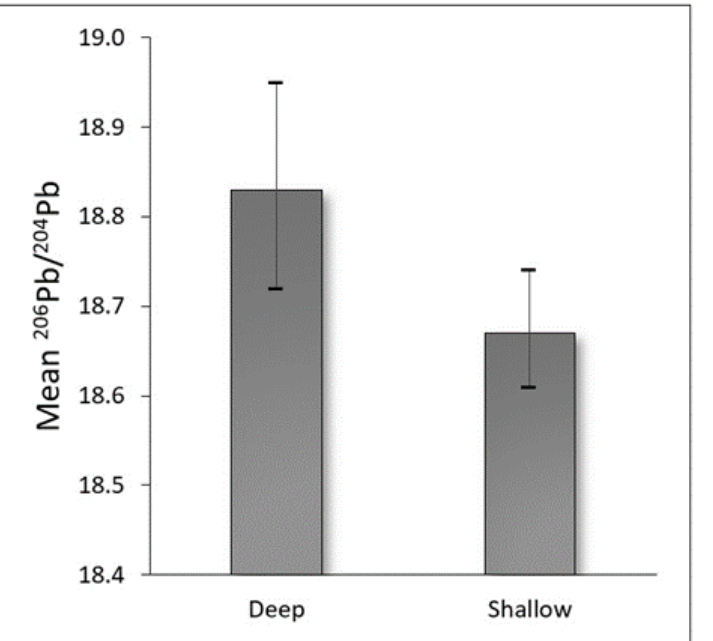
Figure 2. Average 206 Pb/ 204 Pb ratios (with 95% confidence intervals) of shallow and deep soil lead samples.